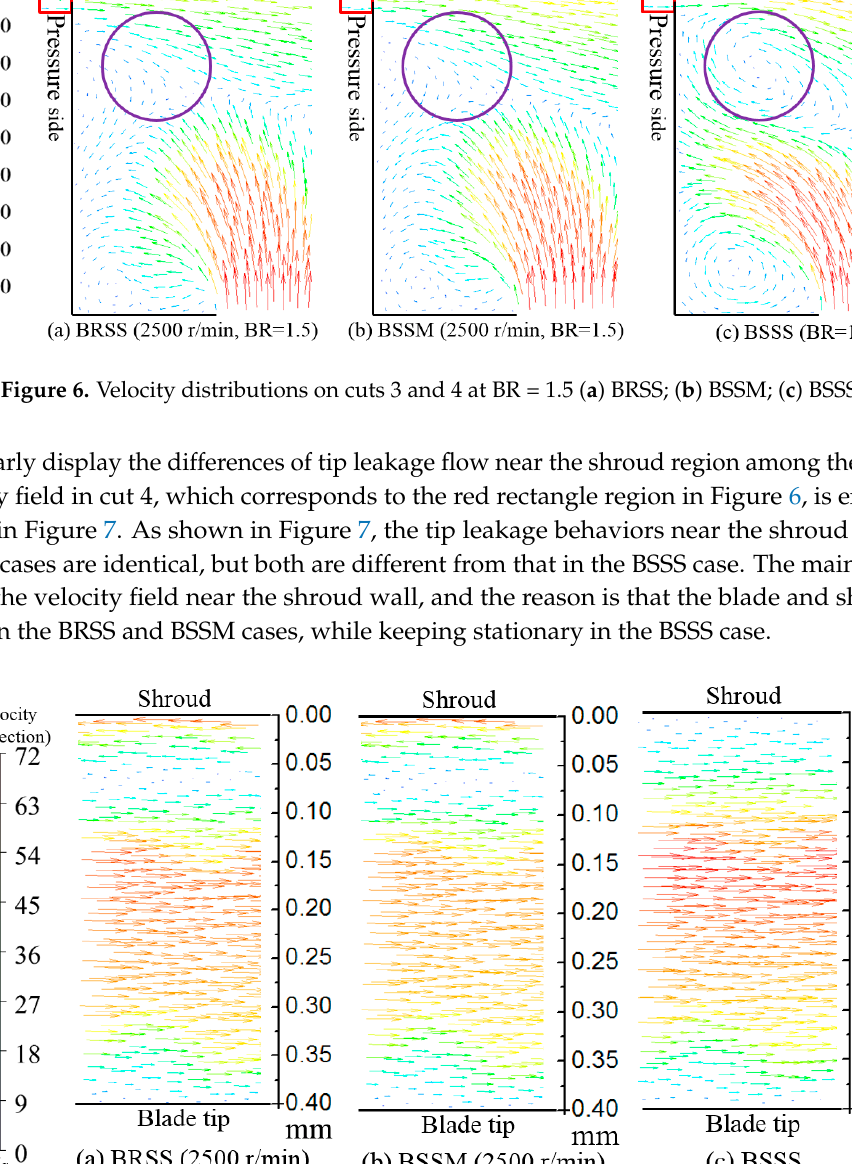
Figure 7. Velocity distributions on cut 4 at BR = 1.5: ( a ) BRSS; ( b ) BSSM; ( c ) BSSS.